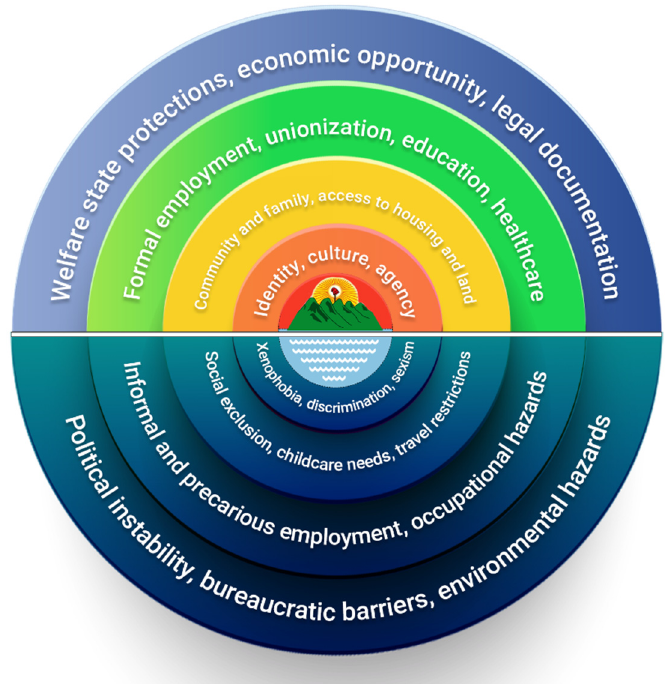
Figure 1. Determinants of migrant health in Central America. Based on the organizing logic of the Dahlgren and Whitehead “rainbow model” [28], the themes emerging from our novel multimodal grounded approach are ordered by individual-level factors; social and community networks; living and working conditions; and socio-economic, political, and environmental conditions. Our themes are further divided between formal determinants on the top of the model and informal determinants at the bottom of the model.